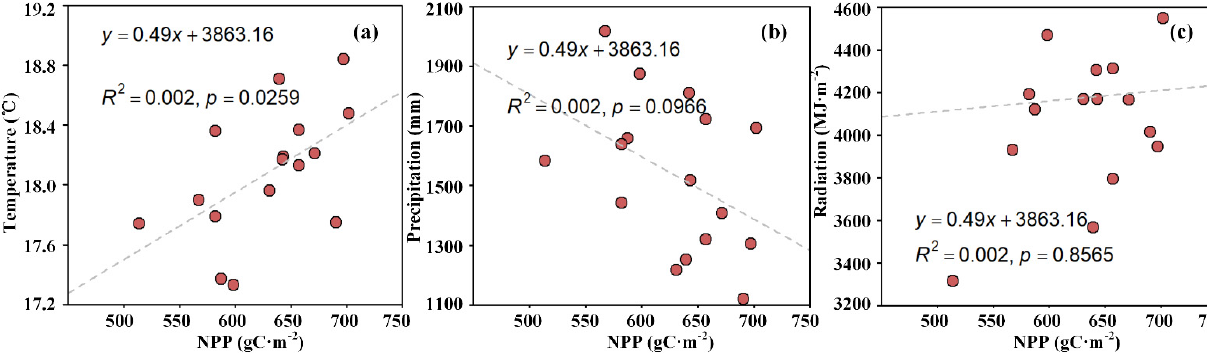
Figure 5. Scatters and fitted linear correlations between annual NPP and ( a ) temperature, ( b ) precipitation, and ( c ) radiation in the CZT urban agglomeration.